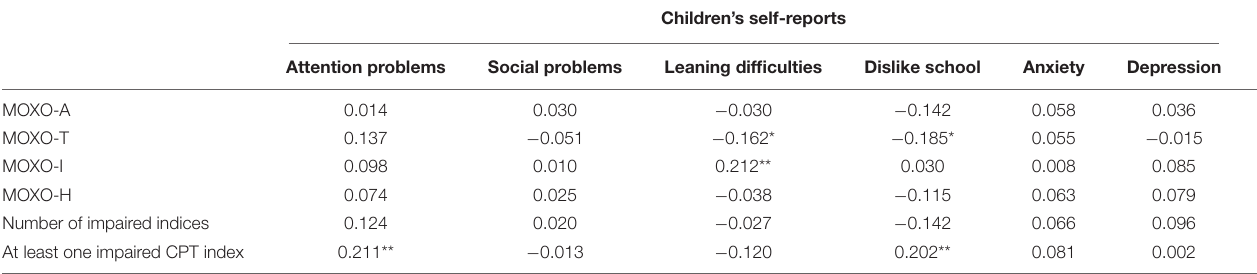
TABLE 3 | Spearman correlations matrix between self-report of ADHD-related symptoms and impaired MOXO-CPT